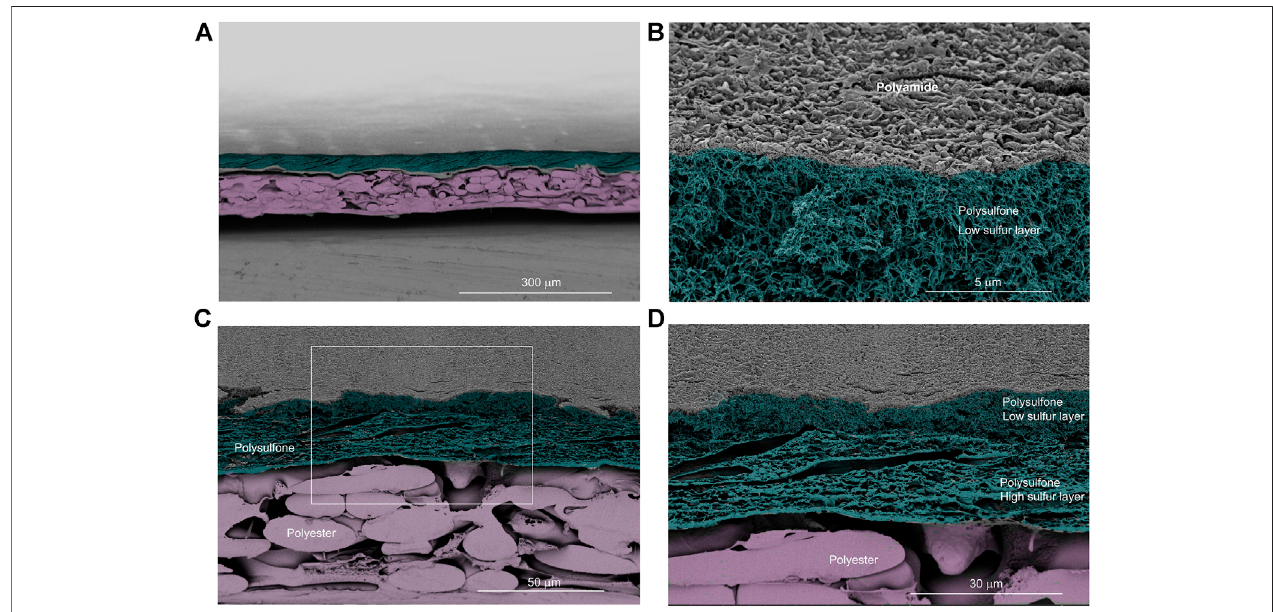
FIGURE 7 | Scanning electron images of cross-sectioned virgin membrane samples. (A) A general overview of the membrane. (B) The virgin polyamide surface layer is visible, and below this, part of the polysulfone is visible. (C) Intact polysulfone layer on top of the polyester layer. (D) Zoomed image of the boxed area from panel (C) showing the two structures of the polysulfone layer. Images were pseudo-colored to ease visualizing the distinctive features of the membrane.